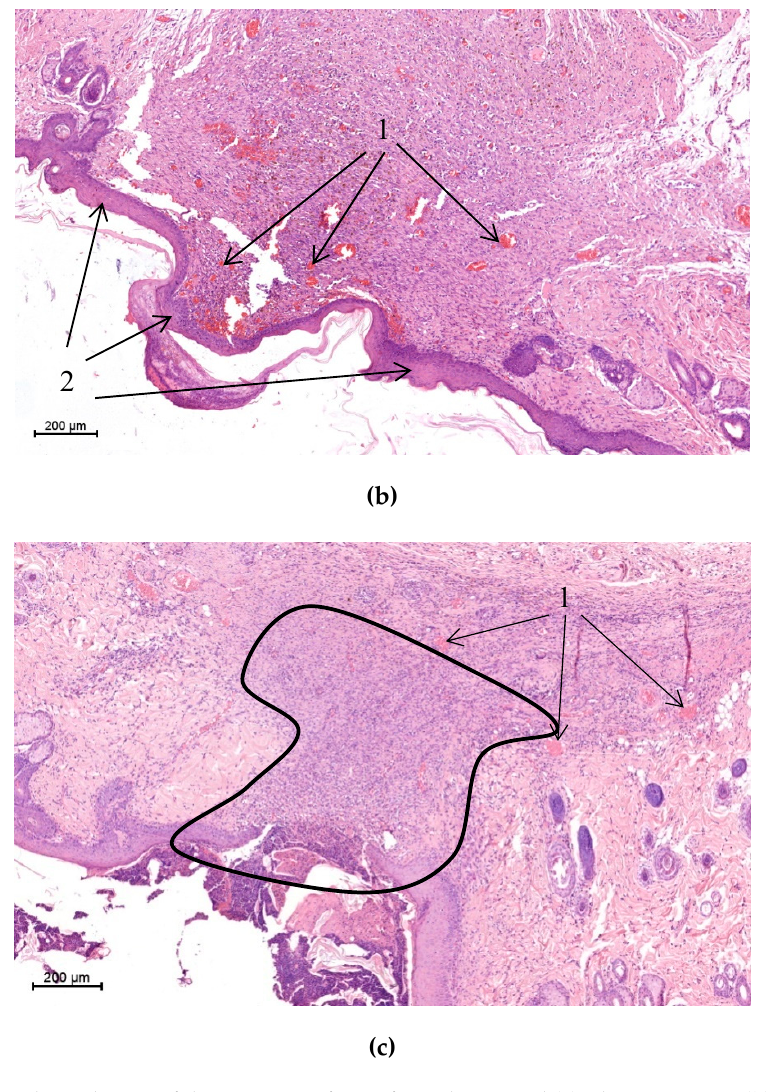
Figure 7. Histological view of the scar area of a rat from the control ( a ), chitosan ‒ CoPA ( b ), and CoPA ( c ) groups (magnification: 5×). The selected areas are neutrophilous leukocytes infiltrated tissues; 1—microvessels; 2—newly formed epithelium.